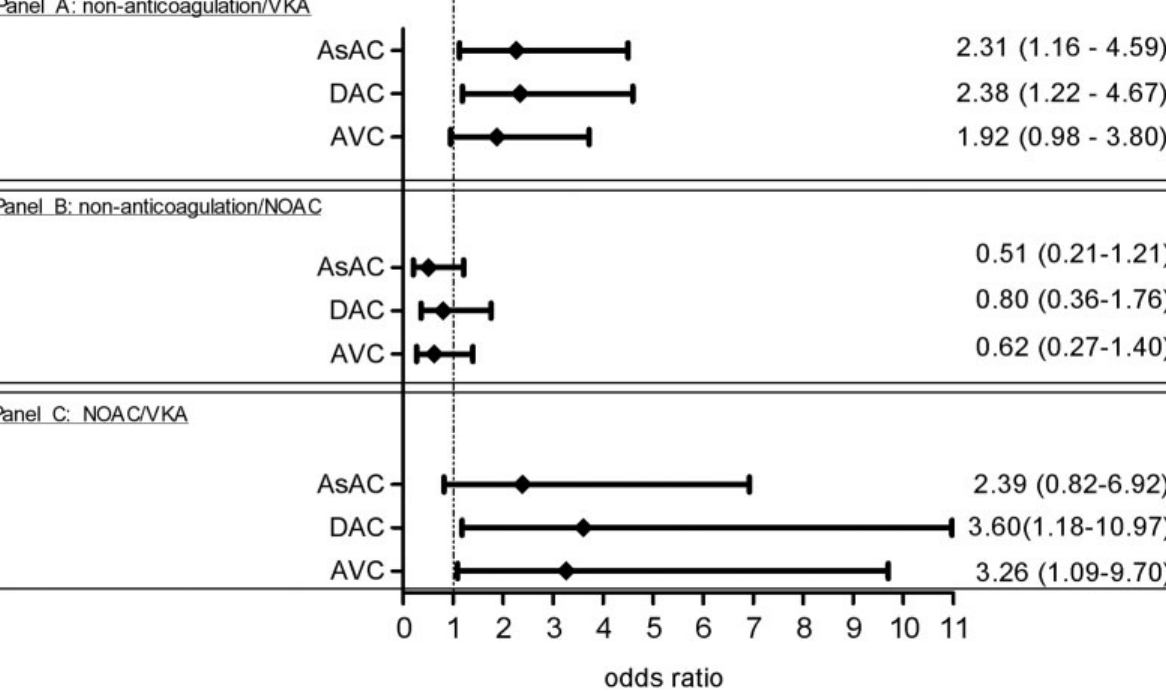
TH Open Vol. 2 No.